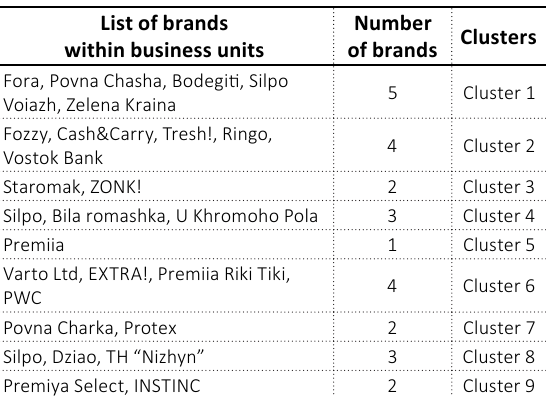
Table 6. Cluster-based brand distribution within